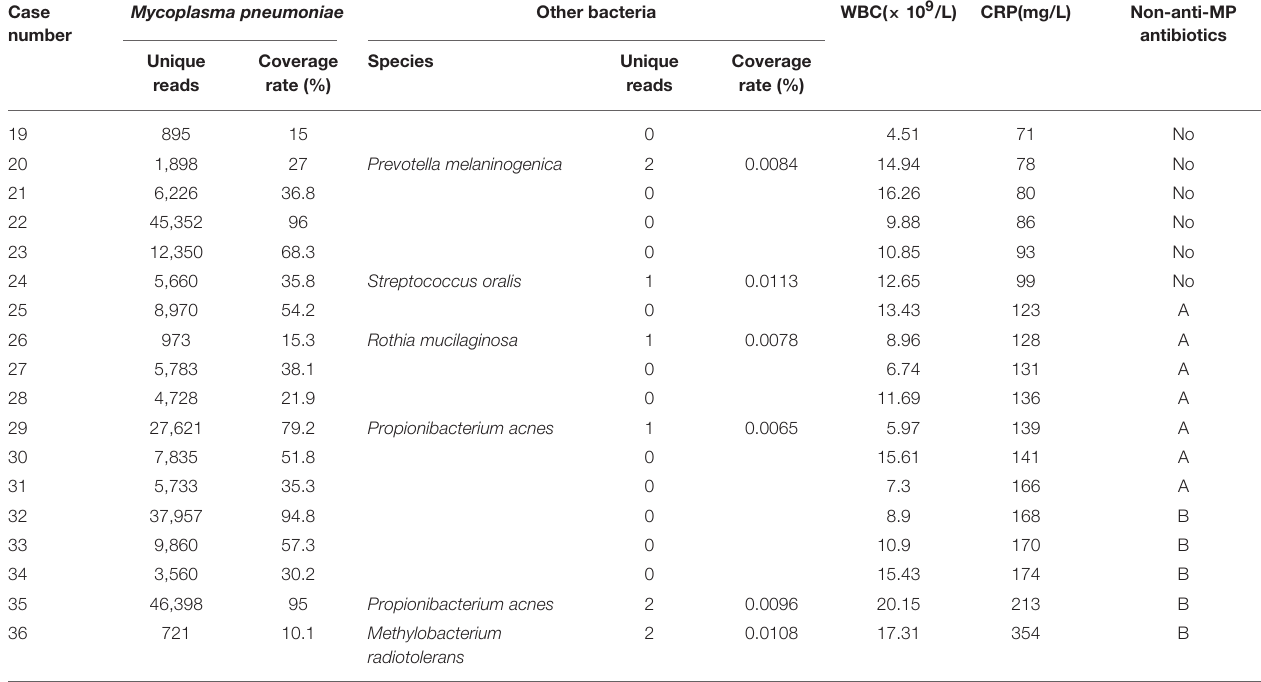
TABLE 3 | Results of Next-generation sequencing in 18 culture-negtive RMPP patients. Case